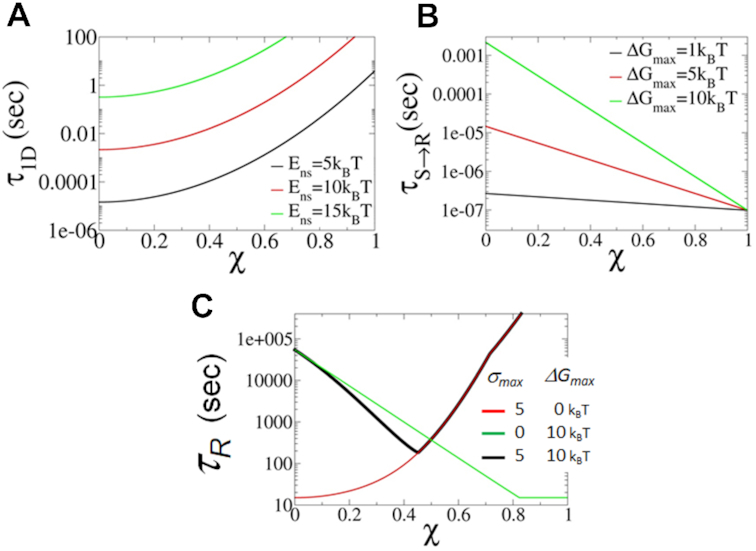
Contribution of the quantified two-state model to understanding the kinetics of DNA recognition. The existence of two states, S and R, are manifested by the similarity index, χ. The larger the value of χ (i.e. the lower the frustration) the greater the similarity of the S and R states. (A) The time scale of 1D diffusion, τ1D, is plotted as a function of the similarity index for three different values of non-specific DNA binding energy, Ens\documentclass[12pt]{minimal}
\usepackage{amsmath}
\usepackage{wasysym}
\usepackage{amsfonts}
\usepackage{amssymb}
\usepackage{amsbsy}
\usepackage{upgreek}
\usepackage{mathrsfs}
\setlength{\oddsidemargin}{-69pt}
\begin{document}
}{}$,{\rm{\ }}$\end{document}using a value for the free energy barrier for recognition of ΔGmax = 5kBT. (B) Transition time from S → R as a function of χ for various values of ΔGmax (τS→R is estimated by kS→R−1). (C) Total recognition time as a function of χ for different values of ΔGmax and σmax (Ens = 5kBT and M is 5 × 106).